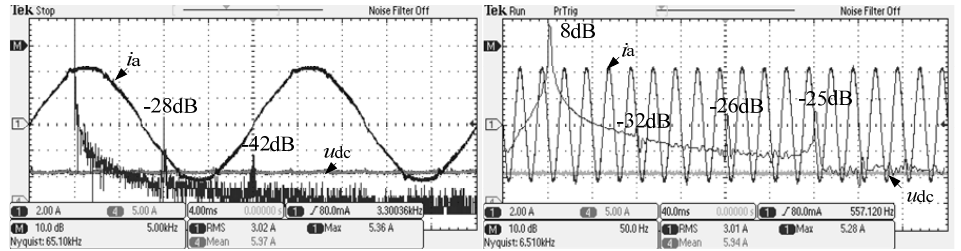
Figure 15. System AC current FFT analysis of the new split inductor solution 2.